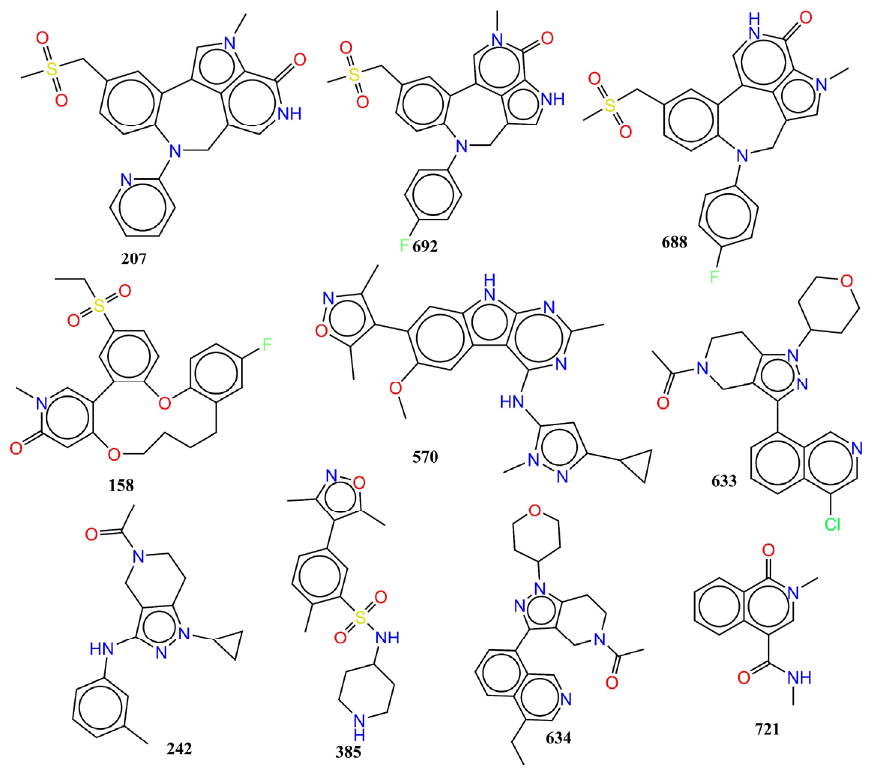
Figure 8. Representative examples to indicate the structural scaffold diversity in the present dataset. Table 2. SMILES notation and IC 50 (nM) and pIC 50 (M) of five most and least active molecules of the selected data